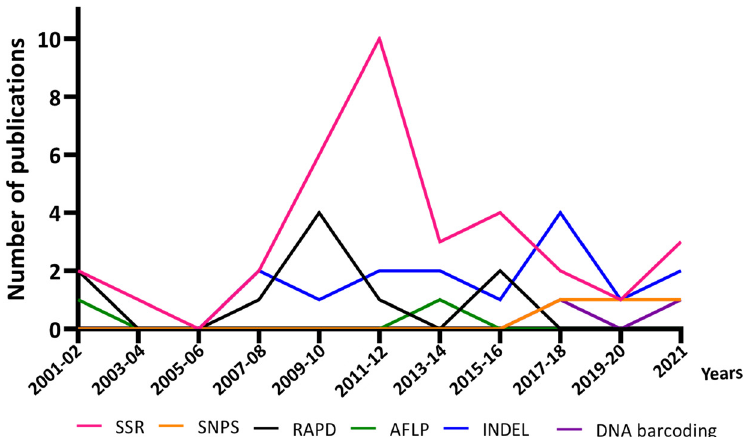
Figure 4. Number of publications per biennium, in the last 20 years, focusing on rice authentication through DNA-based methods. The data were obtained by searching in the SCOPUS database (www.scopus.com; accessed on 18 November 2021) articles published in 2001–2021 using the following terms: (Rice) AND (Authentication), (Rice) AND (Fraud), (Rice) AND (Molecular markers), (Rice) AND (Adulteration) and (Identification) AND (Rice) AND (Varieties). 2001–02: [67,83,87,127]; 2003–04: [128]; 2007–08: [57,60,129–131]; 2009–10: [54,78,130,132–136]; 2011–12: [59,86,116,123,137–142]; 2013–14: [55,58,81,143–145]; 2015–16: [89,111,146–149]; 2017–18: [53,103,108,150–153]; 2019–20: